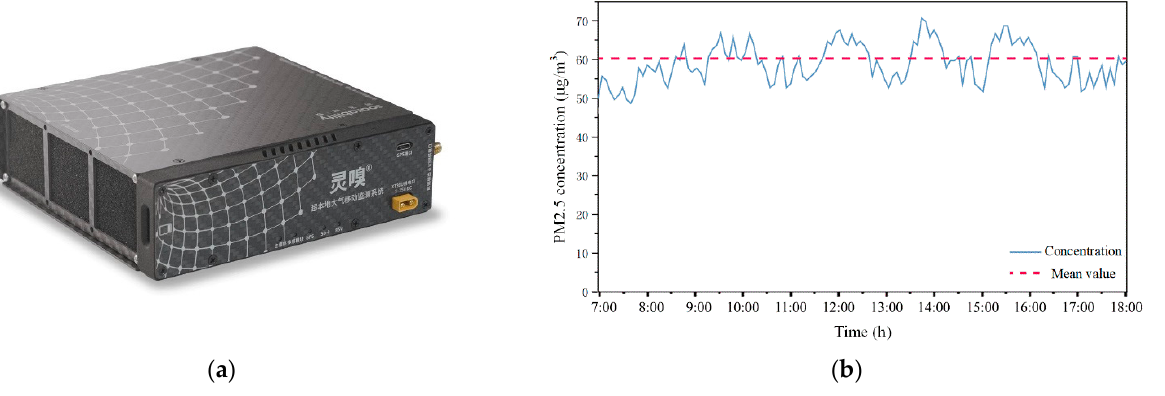
Figure 7. Sniffer 4D and Outdoor PM2.5 concentration measurement results: ( a ) Sniffer 4D instru- ment; ( b ) Measurement results of outdoor PM2.5 concentrations on 11 November 2020. ( b ) Measurement results of outdoor PM2.5 concentrations on 11 November